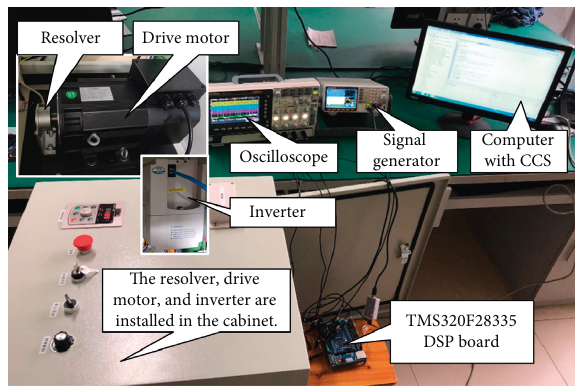
Figure 10: The experiment